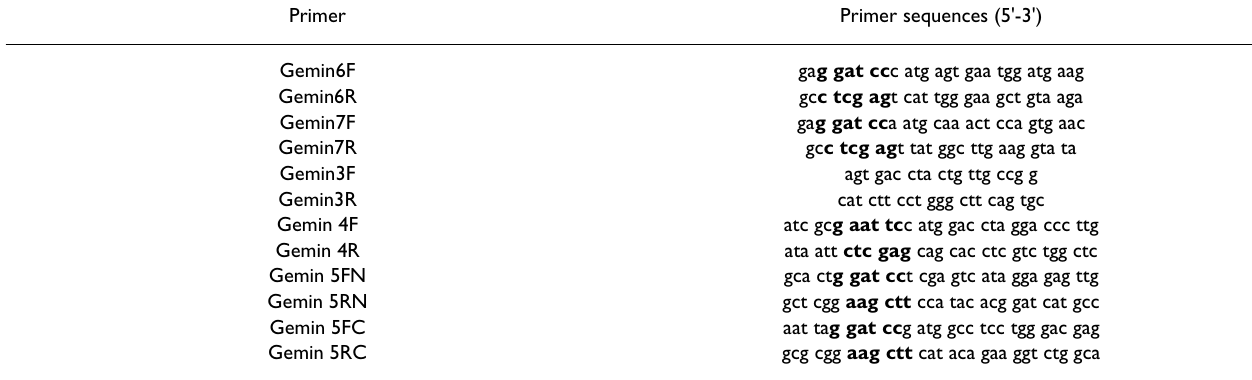
Table 3: Oligonucleotide primers for